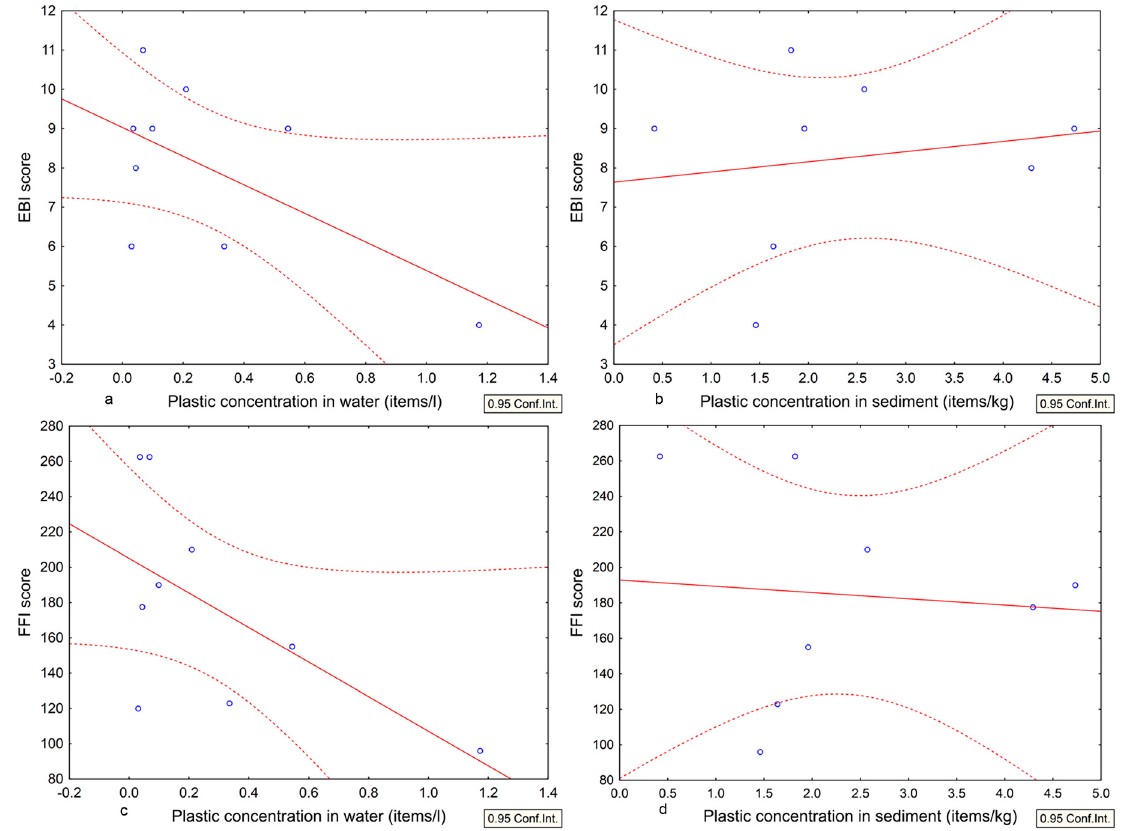
Figure 9. ( a ) Results of EBI compared to the concentration of plastics in water and ( b ) in sediments of each station, and ( c ) results of FFI compared to the concentration of plastics in water and ( d ) in sediments of each station.